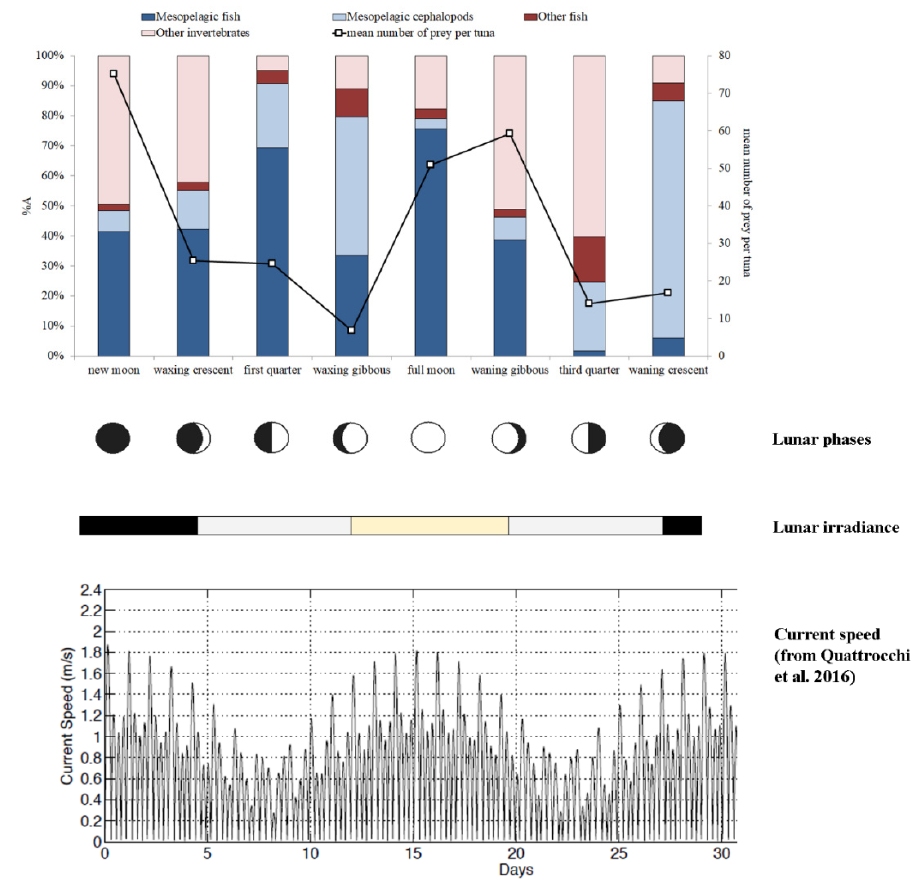
Figure 2. Relative percentage abundance (%A) of food categories consumed by Thunnus thynnus during the different moon phases (bar plots). The mean number of preys per tuna across the lunar cycle is also present (line). The lunar irradiance and current strength are also shown for the entire lunar cycle. Lunar irradiance: black = low intensity; grey = medium intensity; yellow = high intensity. Shown as well is a time series of current strength observed during an entire lunar cycle in the Strait of Messina (graph modified from Quattrocchi et al. [64]).